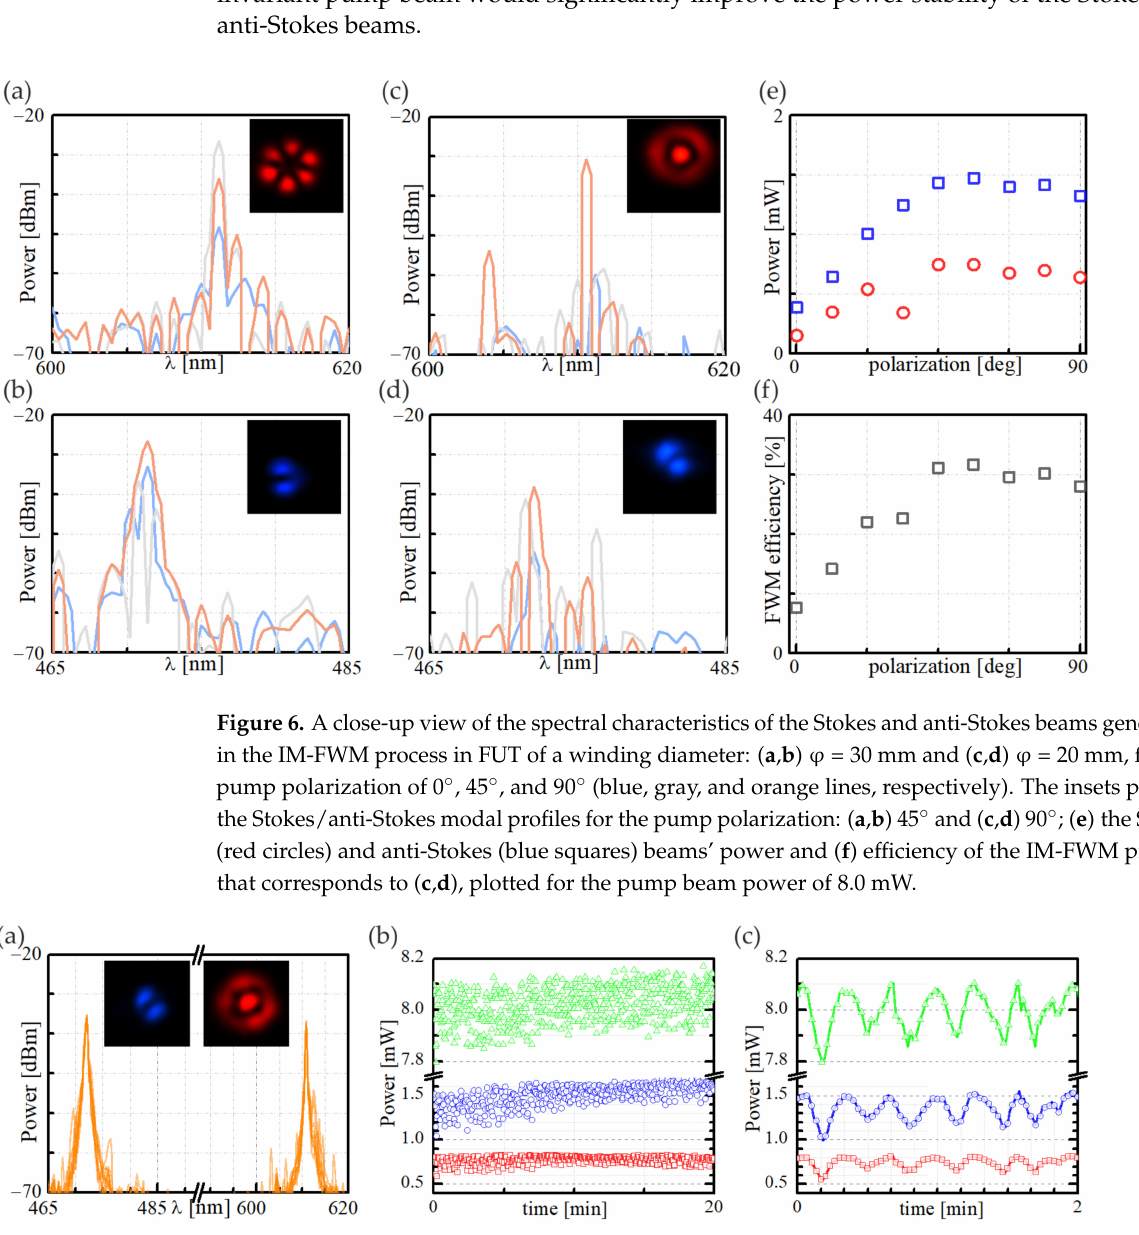
Figure 7. Stability of the IM-FWM process in wound FUT ( ϕ = 20 mm) for the pump beam polarized orthogonal to the winding plane: ( a ) spectral characteristics recorded over 20 min in two-minute increments. The insets present the Stokes ( left ) and anti-Stokes ( right ) modal field profiles; ( b ) the power of the Stokes (red squares), anti-Stokes (blue circles), and pump beam (green triangles) within 20 min; ( c ) an enlarged section of the graph ( b